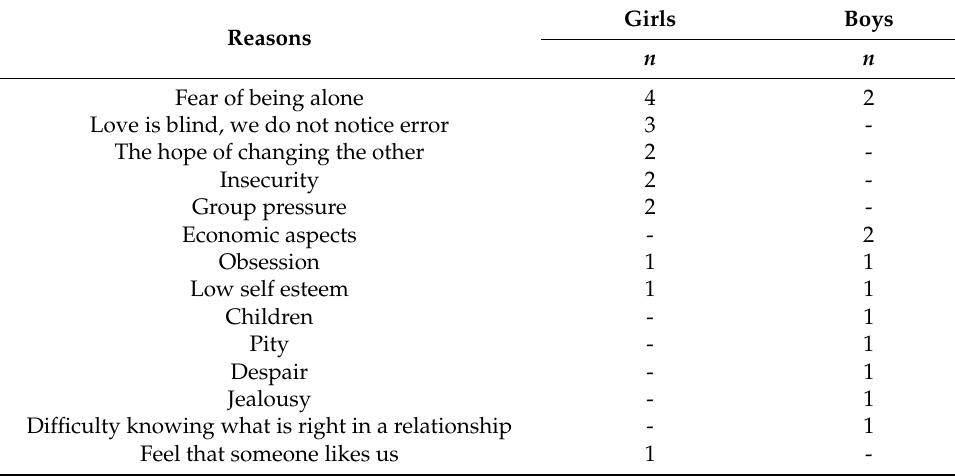
Table 6. Reasons why adolescents remain in an unhealthy